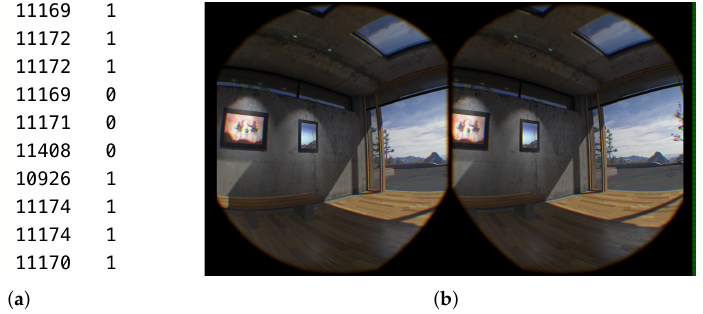
Figure 5. Example traces produced by the monitoring: ( a ) Excerpt of the text trace obtained for a transmitter-receiver distance of d = 7.5m and 270 ◦ initial HMD direction (first column: frame number; second column: measured inter-frame time in micro-seconds (11169 µ s relating to a nominal frame rate of 89.53 fps); third column: flow indicator (0 = freeze, 1 = no freeze), ( b ) Video trace sample of “SteamVR home screen” [24] given as screenshot of the first frozen frame, here frame number 3474 with HMD residing in